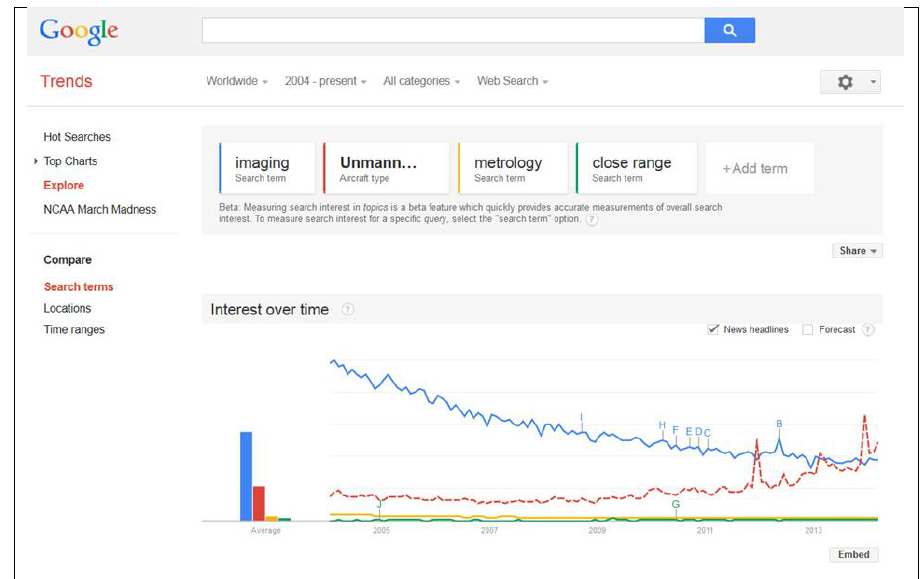
Figure 3. Examining the popularity of the terms “Imaging”, “UAV”, “Metrology”, “Close-range” It is very interesting to uncover the rather predictable fact that the terms “Metrology” or “Close-range” are rather unknown to the public, rarely used, and this is a general trend over the last years.